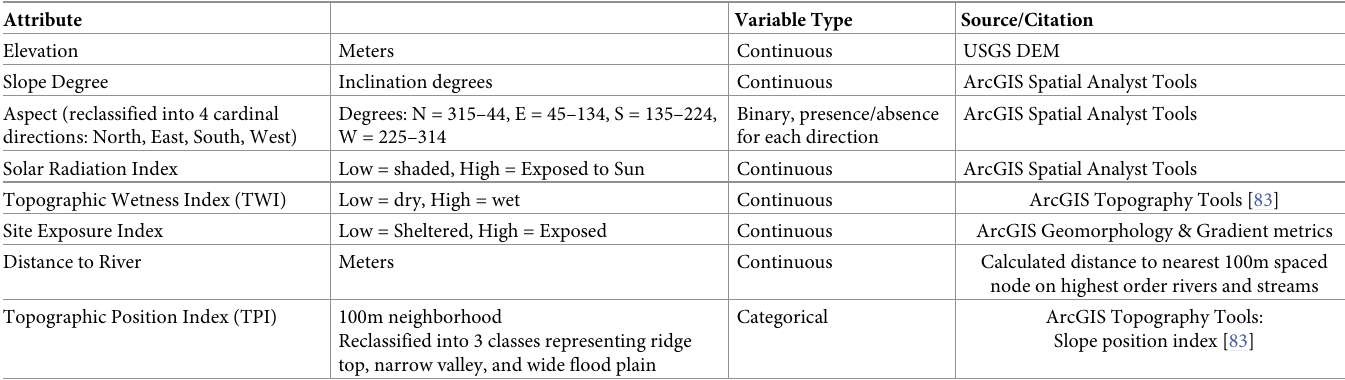
Table 2. Environmental and topographic parameters.